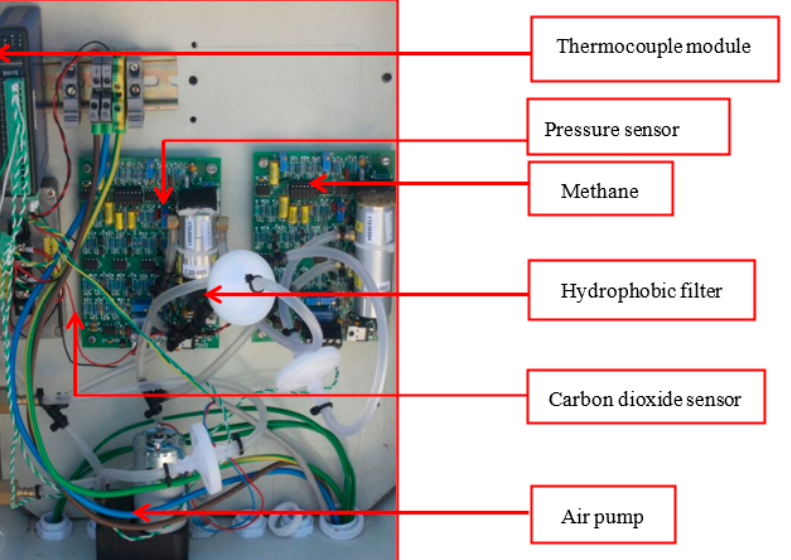
Figure 2. The gas–temperature–pressure monitoring system (GTPMS).